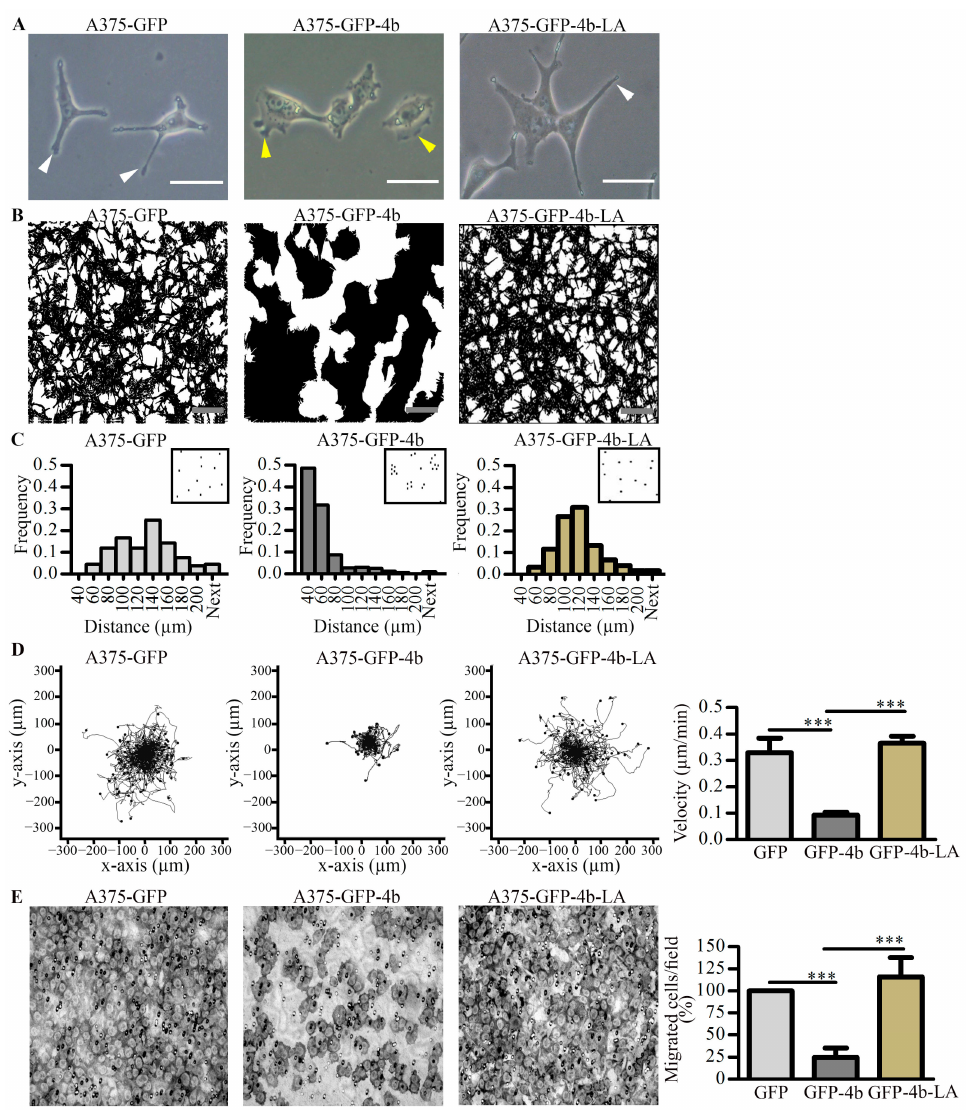
Figure 1. PMCA4b but not the trafficking mutant PMCA4b-LA changed shape, culture morphology, and migration-type of A375 cells. (A+B) A375-GFP, A375-GFP-PMCA4b, and A375-GFP-PMCA4b-LA cells were cultured in a 6-well plate. After overnight attachment and at 80% confluency images were taken using a phase-contrast microscope. Cell culture morphology was highlighted by applying a black mask to display the contour of the cells. White and yellow arrowheads show protrusions and lamellipodia, respectively. Scale bar, ( A ) 10 µ m and ( B ) 50 µ m. ( C ) After 48 h in culture, phase-contrast microscopy images were taken. Cell centers were determined and nearest neighbor distances were calculated from the binary images. Insets show the center of cells, as dots. ( D ) Cells were cultured in a 96-well plate and stained with Hoechst 33342. Migratory activity of the cells was followed by recording Hoechst and GFP signals by automated fluorescence microscopy for 24 h. Single cell trajectories of A375-GFP ( n = 130), A375-GFP-PMCA4b ( n = 77), and A375-GFP-PMCA4b-LA ( n = 101) with the starting position of each trajectory translated to the origin of the plot are shown. Mean velocity ± S.D was determined from single cell trajectories (A375-GFP ( n = 645), A375-PMCA4b ( n = 941), and A375-PMCA4b-LA ( n = 990) of 4–5 independent measurements. ( E ) For directional cell migration Boyden chamber assay was performed. Cells were seeded into the upper chamber and left to migrate for 3 h through the filter membrane towards the fibronectin at the lower chamber. Cells at the bottom of the filter membrane were fixed and stained with Toluidine blue. The number of migrated cells from six field of view was counted. Data show the means (% relative to the control) ± S.E.M from three independent experiments (*** p <